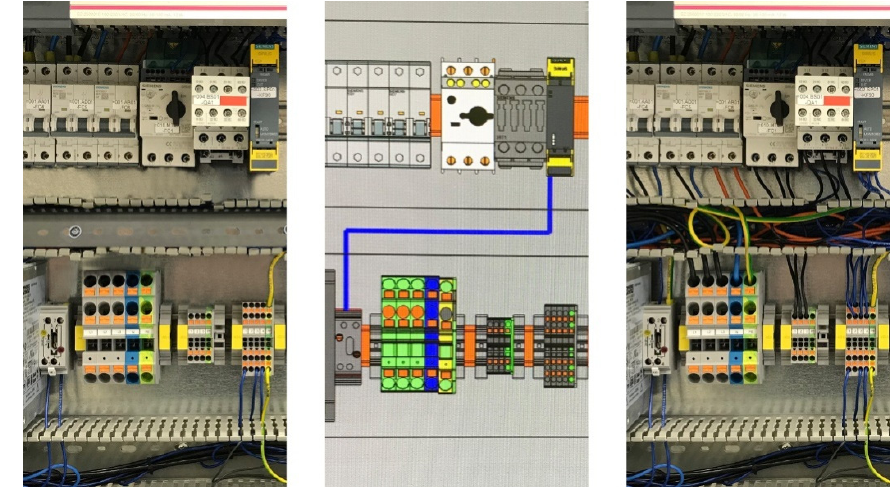
Figure 2. Wire assembly process – left photograph: an industrial enclosure with assembled components; middle graphic: wire assembly instruction for single blue wire (digital twin with the 3D graphics from ESW system); right photograph: wiring completed. Photographs: Szajna A.